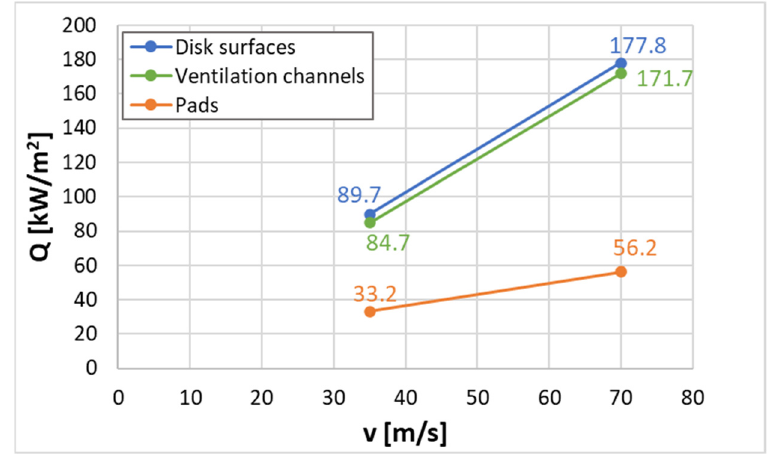
Figure 15. Heat flux removed from the main components at different car speeds—thermal convection only.